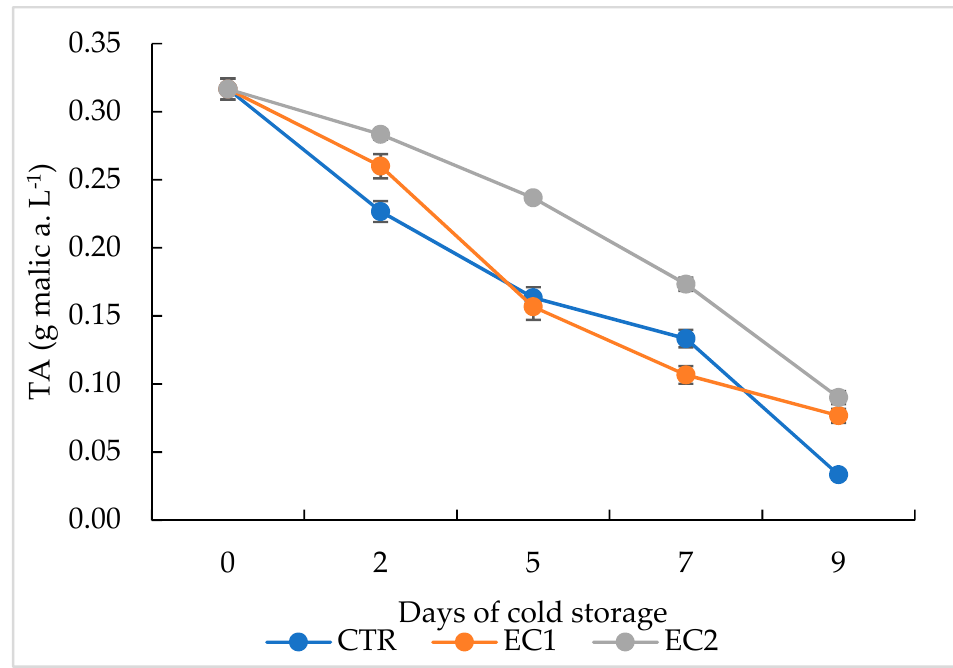
Figure 6. Evolution of titratable acidity (TA) measured during 9 days of cold storage. Data correspond to the mean and bars indicate the standard deviation (SD) of three replicates (n = 3).